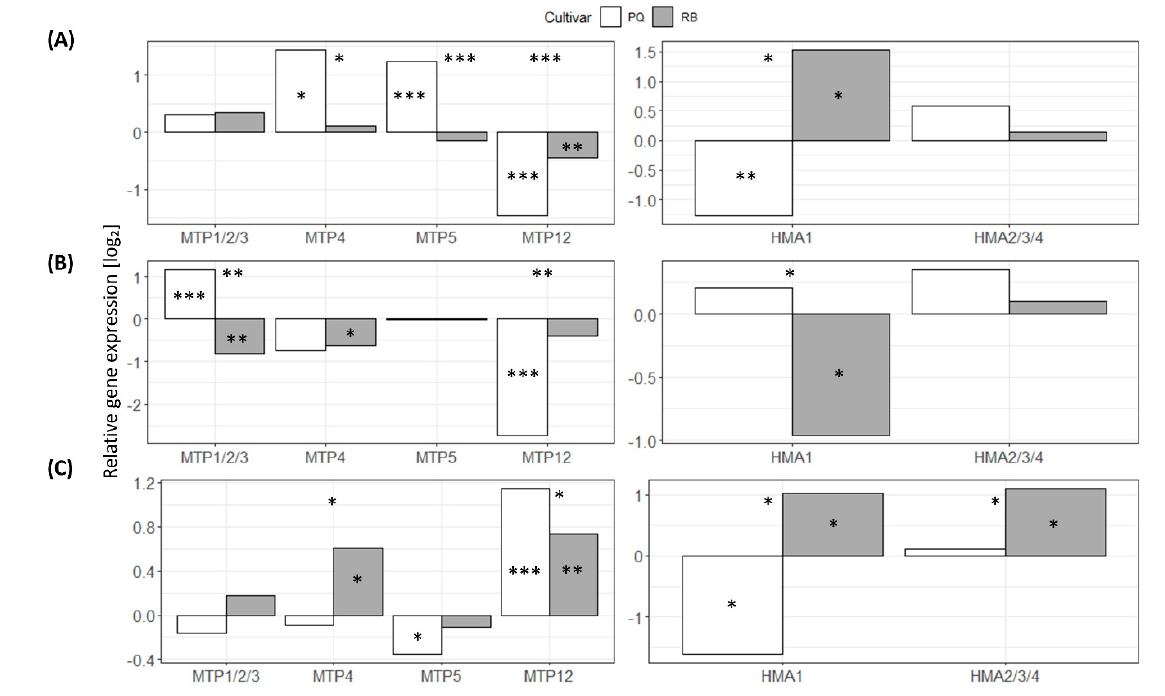
Figure 5. Relative expression of MTP and HMA genes in roots ( A ), stems ( B ) and leaves ( C ) of PQ (Hybrid F1 Purple Queen) and RB (Rotonda Bianca Sfumata di Rosa). Gene expression was evaluated after 15 days on plantlets growing in hydroponic culture with 5 μ M Cd. The log 2 of gene expression calculated using the 2 −ΔΔ Ct method is reported in the graph. Statistical comparison was performed using Student’s t-test; statistical differences with control samples are represented inside the bar plots; statistical differences between the two cultivars are represented outside the bar plots (* = p ≤ 0.05, ** = p ≤ 0.01; *** = p ≤ 0.001).